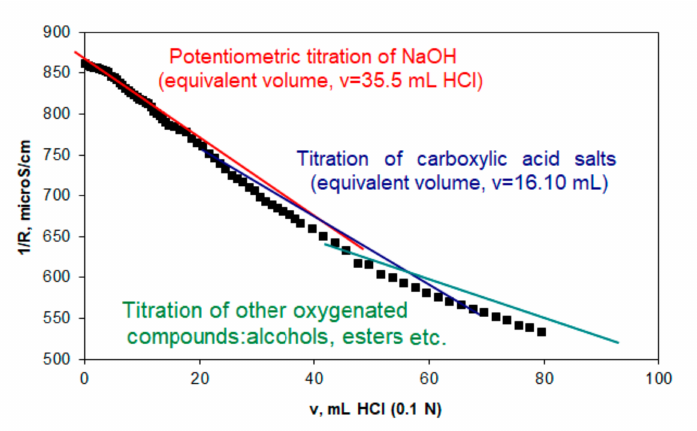
Figure 4. The potentiometric titration of β -keratose